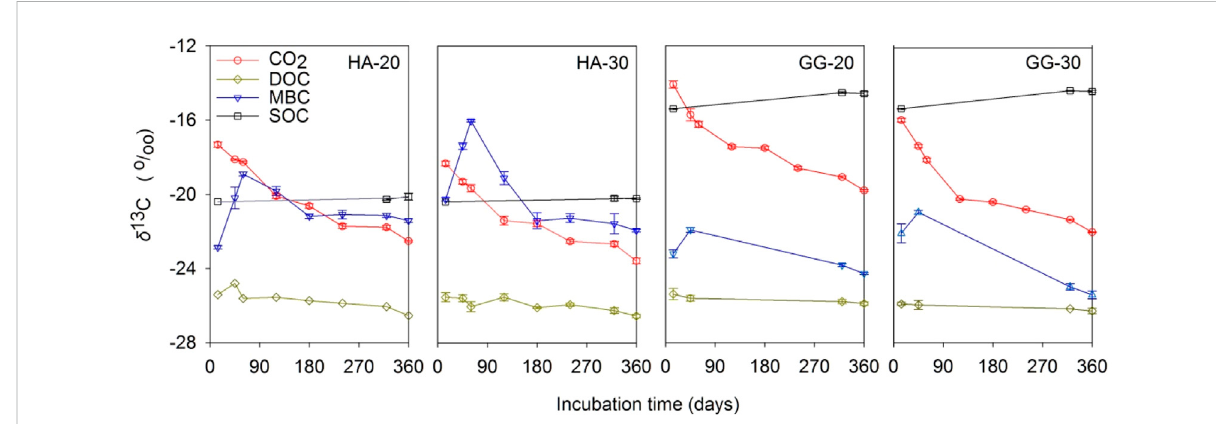
FIGURE 1 The effect of temperature on the δ 13 C dynamics in C pools during incubation of the soil after C 3 -C 4 vegetation change. Bars indicate standard errors (SE, n =